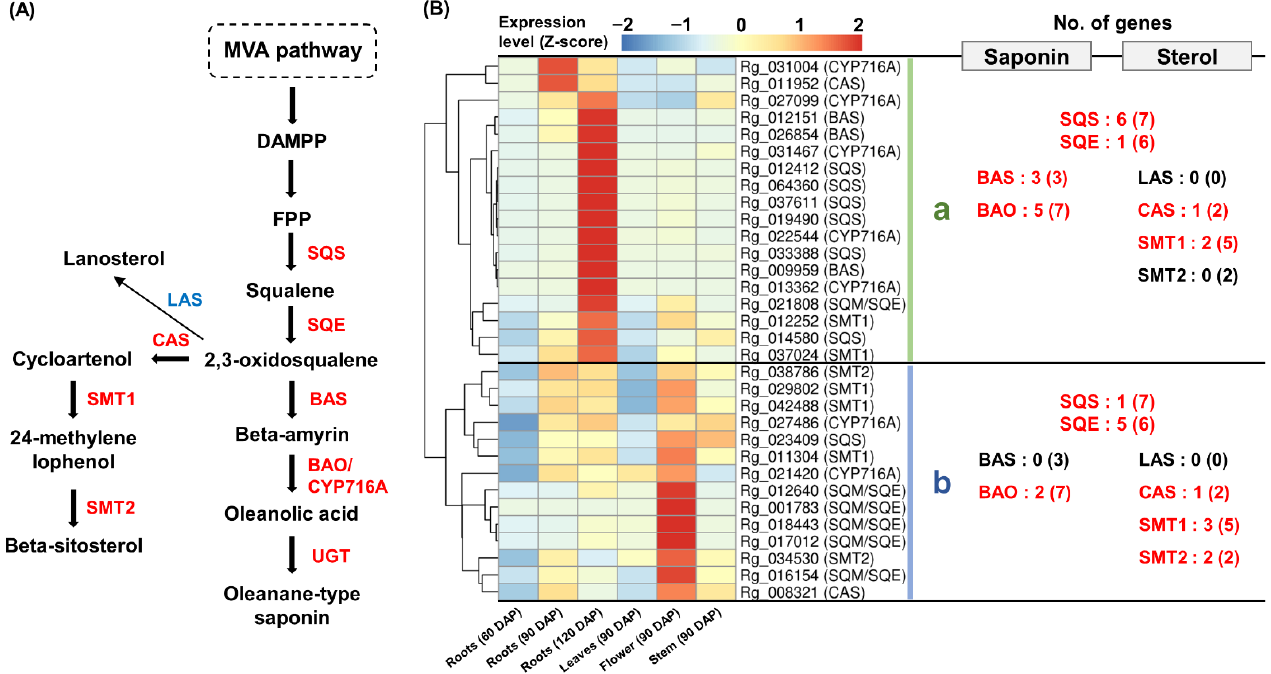
Figure 5. Expression analysis of genes involved in triterpenoid saponin and sterol. ( A ) Saponin and beta ‐ sitosterol biosynthetic pathway in plants. Genes that were missing in this study and genes with <5 TPM values are shown in blue. ( B ) Heatmap analysis of genes responsible for saponin and sterol biosynthesis. (a) Genes cluster showing a strong expression in the 120 DAP roots. (b) Genes cluster showing a constitutive expression in most tissues. Genes highlighted in red indicate genes assigned to each cluster and the number in parentheses is the total number of genes encoding the enzyme expressed in R. glutinosa transcriptome. TPM, transcripts per million.